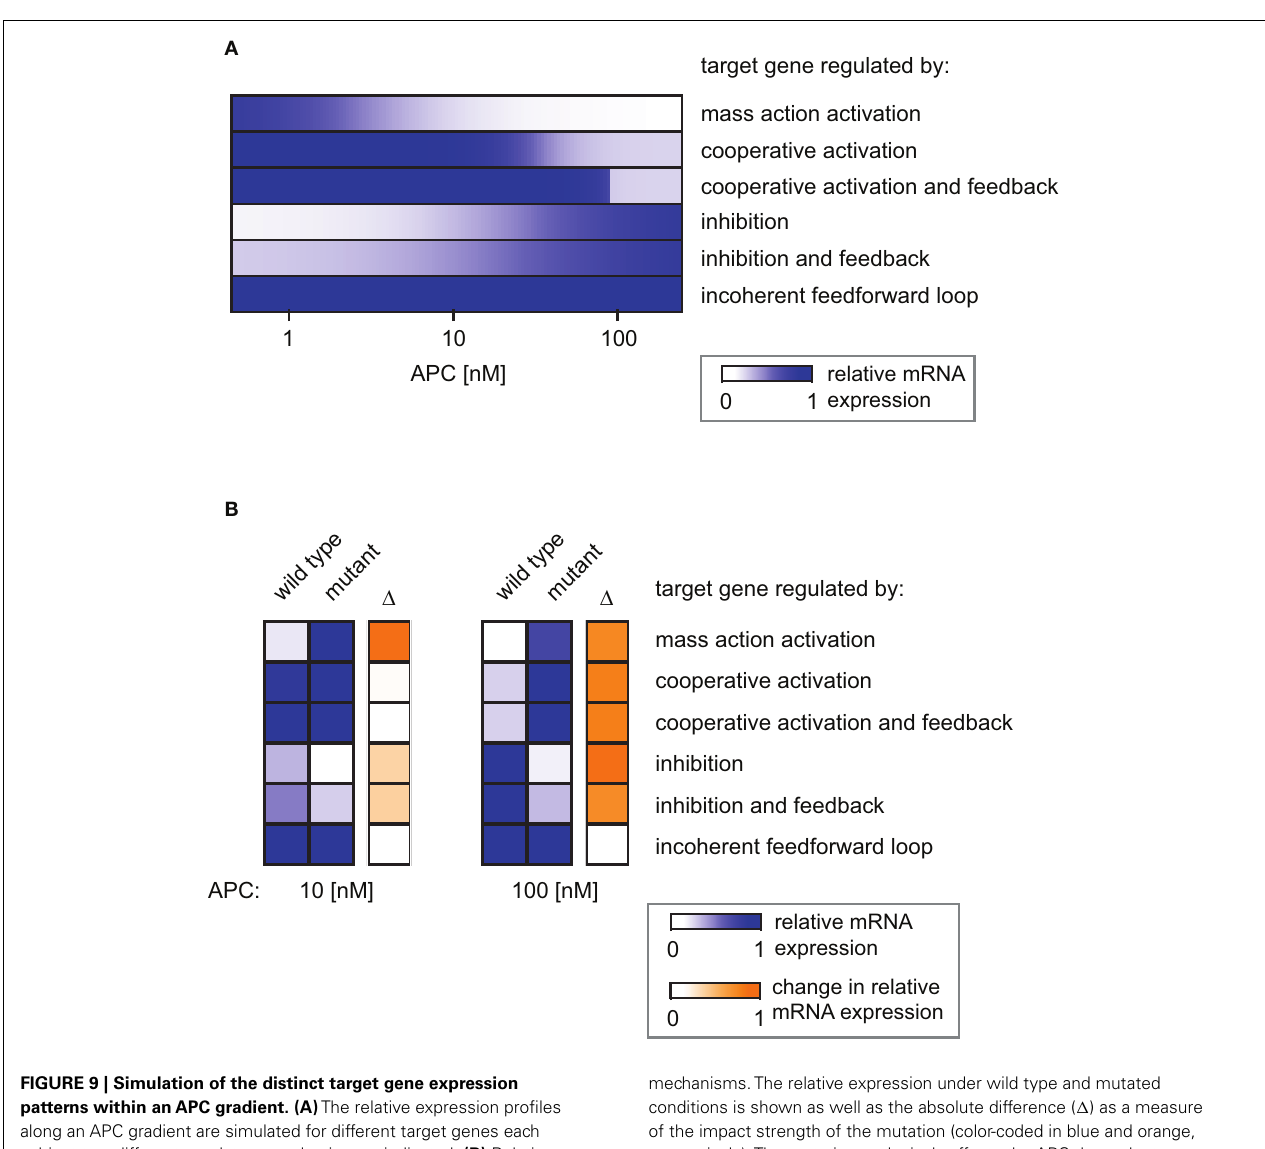
FIGURE 9 | Simulation of the distinct target gene expression patterns within anAPC gradient. (A) The relative expression profiles along an APC gradient are simulated for different target genes each subject to a different regulatory mechanism as indicated. (B) Relative mRNA expression at two positions in the APC gradient ( APC = 10nM, left, and APC = 100nM, right) for the six indicated gene regulatory